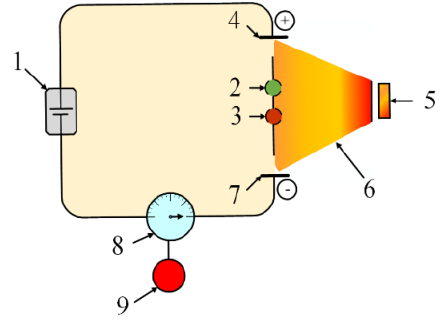
Figure 1. Ionization smoke detector scheme [31]: 1—electrical power source; 2—negative ion; 3—positive ion; 4—positive electrode; 5—alpha source; 6—alpha particles; 7—negative electrode; 8—current detector;